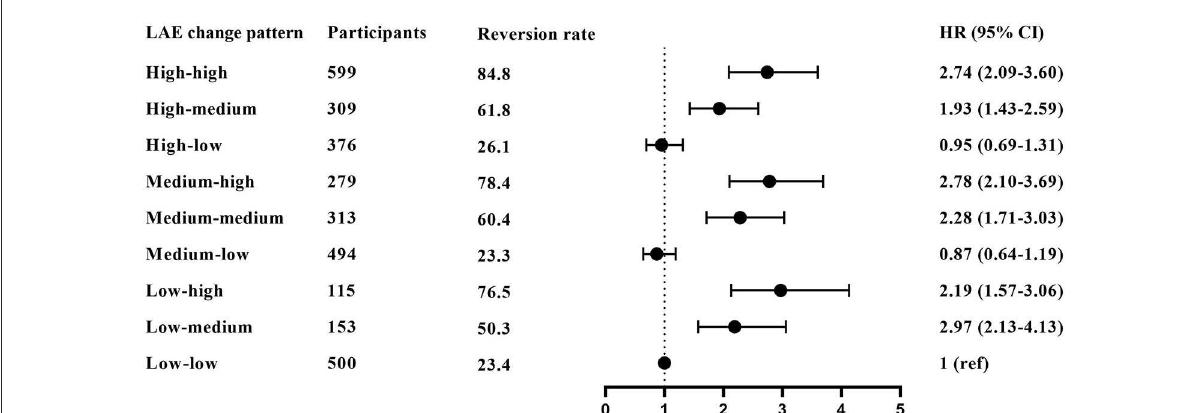
FIGURE3 The association between overall LAE change patterns and MCI reversion. The results derived from the full-adjusted models were presented as hazard ratios with 95% confidential intervals. The model adjusted for sex, age, residence, years of schooling, marital status, economic status, living pattern, number of people living with, smoking, alcohol drinking, activity of daily living (ADL), instrumental activity of daily living (IADL), and chronic disease (such as hypertension, diabetes, heart disease, stroke or CVD, cataract, digestive system diseases, arthritis, and Parkinson’s